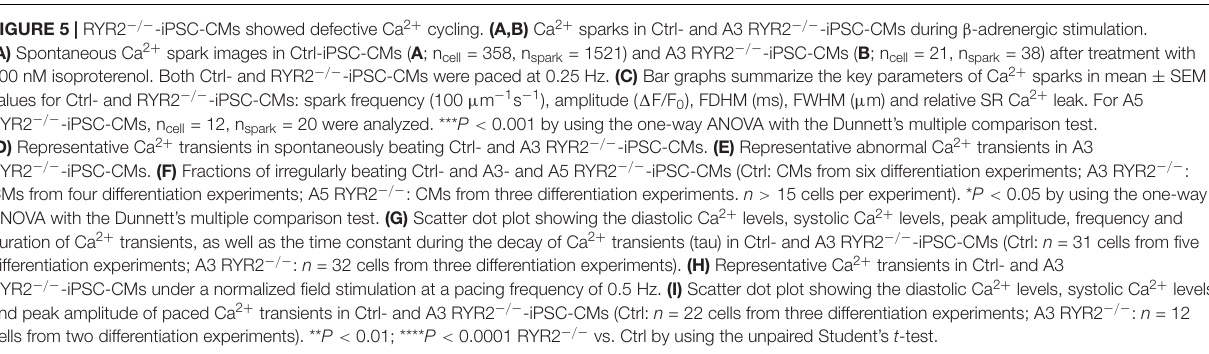
FIGURE 5 | RYR2 − / − -iPSC-CMs showed defective Ca 2 + cycling. (A,B) Ca 2 + sparks in Ctrl- and A3 RYR2 − / − -iPSC-CMs during β -adrenergic stimulation. (A) Spontaneous Ca 2 + spark images in Ctrl-iPSC-CMs ( A ; n cell = 358, n spark = 1521) and A3 RYR2 − / − -iPSC-CMs ( B ; n cell = 21, n spark = 38) after treatment with 100 nM isoproterenol. Both Ctrl- and RYR2 − / − -iPSC-CMs were paced at 0.25 Hz. (C) Bar graphs summarize the key parameters of Ca 2 + sparks in mean ± SEM values for Ctrl- and RYR2 − / − -iPSC-CMs: spark frequency (100 µ m − 1 s − 1 ), amplitude ( (cid:49) F/F 0 ), FDHM (ms), FWHM ( µ m) and relative SR Ca 2 + leak. For A5 RYR2 − / − -iPSC-CMs, n cell = 12, n spark = 20 were analyzed. *** P < 0.001 by using the one-way ANOVA with the Dunnett’s multiple comparison test. (D) Representative Ca 2 + transients in spontaneously beating Ctrl- and A3 RYR2 − / − -iPSC-CMs. (E) Representative abnormal Ca 2 + transients in A3 RYR2 − / − -iPSC-CMs. (F) Fractions of irregularly beating Ctrl- and A3- and A5 RYR2 − / − -iPSC-CMs (Ctrl: CMs from six differentiation experiments; A3 RYR2 − / − : CMs from four differentiation experiments; A5 RYR2 − / − : CMs from three differentiation experiments. n > 15 cells per experiment). * P < 0.05 by using the one-way ANOVA with the Dunnett’s multiple comparison test. (G) Scatter dot plot showing the diastolic Ca 2 + levels, systolic Ca 2 + levels, peak amplitude, frequency and duration of Ca 2 + transients, as well as the time constant during the decay of Ca 2 + transients (tau) in Ctrl- and A3 RYR2 − / − -iPSC-CMs (Ctrl: n = 31 cells from five differentiation experiments; A3 RYR2 − / − : n = 32 cells from three differentiation experiments). (H) Representative Ca 2 + transients in Ctrl- and A3 RYR2 − / − -iPSC-CMs under a normalized field stimulation at a pacing frequency of 0.5 Hz. (I) Scatter dot plot showing the diastolic Ca 2 + levels, systolic Ca 2 + levels and peak amplitude of paced Ca 2 + transients in Ctrl- and A3 RYR2 − / − -iPSC-CMs (Ctrl: n = 22 cells from three differentiation experiments; A3 RYR2 − / − : n = 12 cells from two differentiation experiments). ** P < 0.01; **** P < 0.0001 RYR2 − / − vs. Ctrl by using the unpaired Student’s t